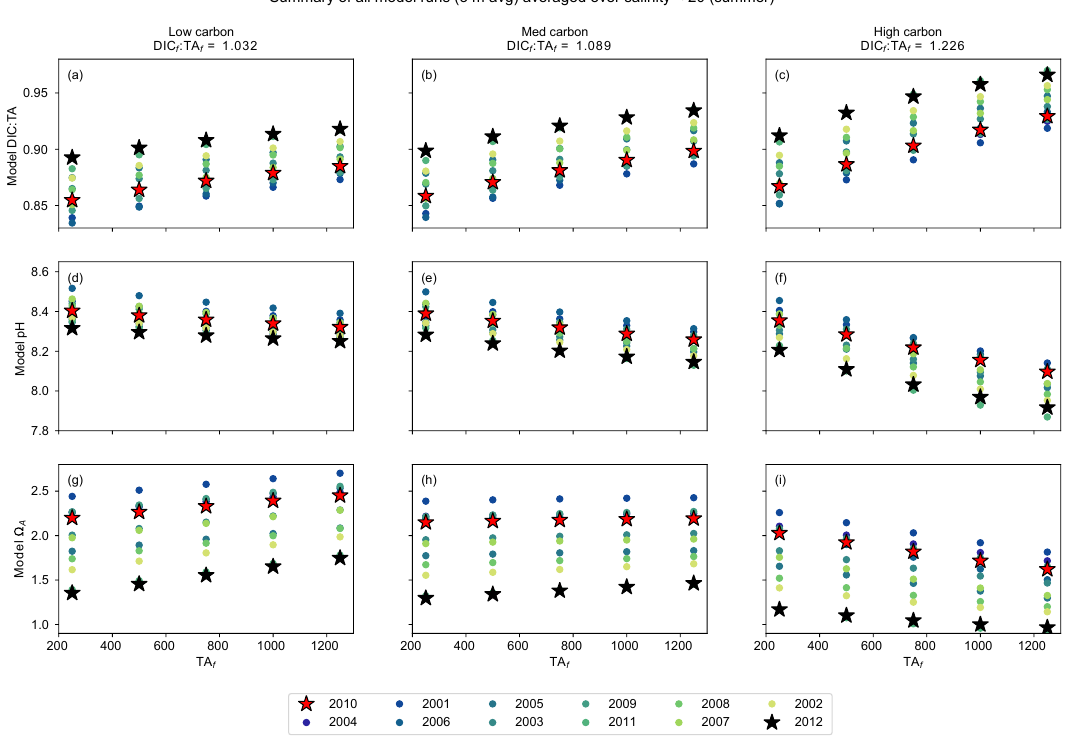
Figure 6. Salinity-averaged (salinity<20, summer) model (a–c) DIC:TA, (d–f) pH, and (g–i) (cid:127) A under the (left column) Low Carbon, (center column) Med Carbon, and (right column) High Carbon scenarios between all constant TA f cases (horizontal axis) for each year in the full 12-year period (2001–2012). The salinity<20 averages (circles) are plotted in order of increasing freshet size, with the smallest (2010) and largest (2012) years highlighted as red and black stars, respectively, as in Fig. 3. Model DIC:TA (pH) generally increases (decreases) with increasing TA f . Model (cid:127) A shares this trend under the High Carbon scenario, but follows an opposite trend under the Low Carbon